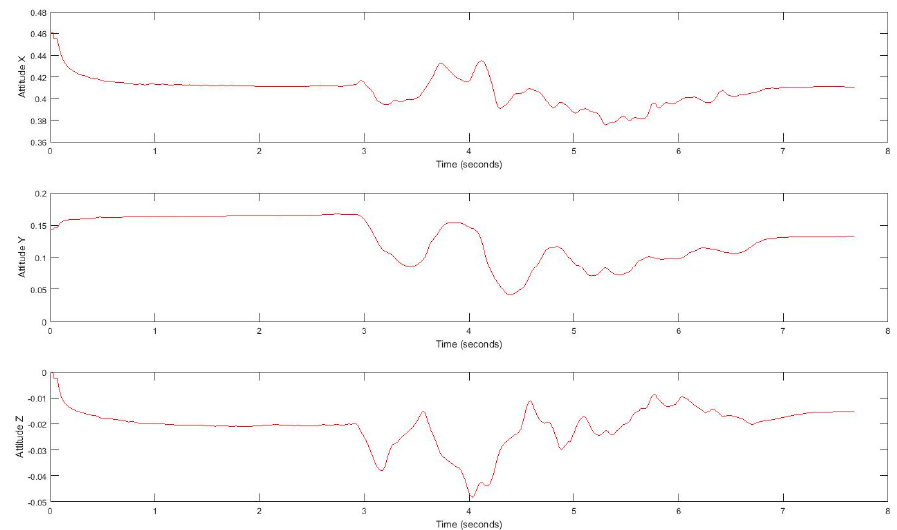
Figure 3. Tandem gait linear attitude signal.